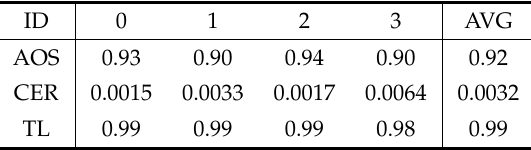
Figure 7. Tracking results on computer generated hazardous situation on a heavy rainy day. Green rectangles denote ground truth labels whereas differently-colored rectangles illustrate the tracked pedestrian workers. Table 4. Tracking results of our system on synthetic scene 3. IDs are assigned randomly and correspond to a single tracked worker